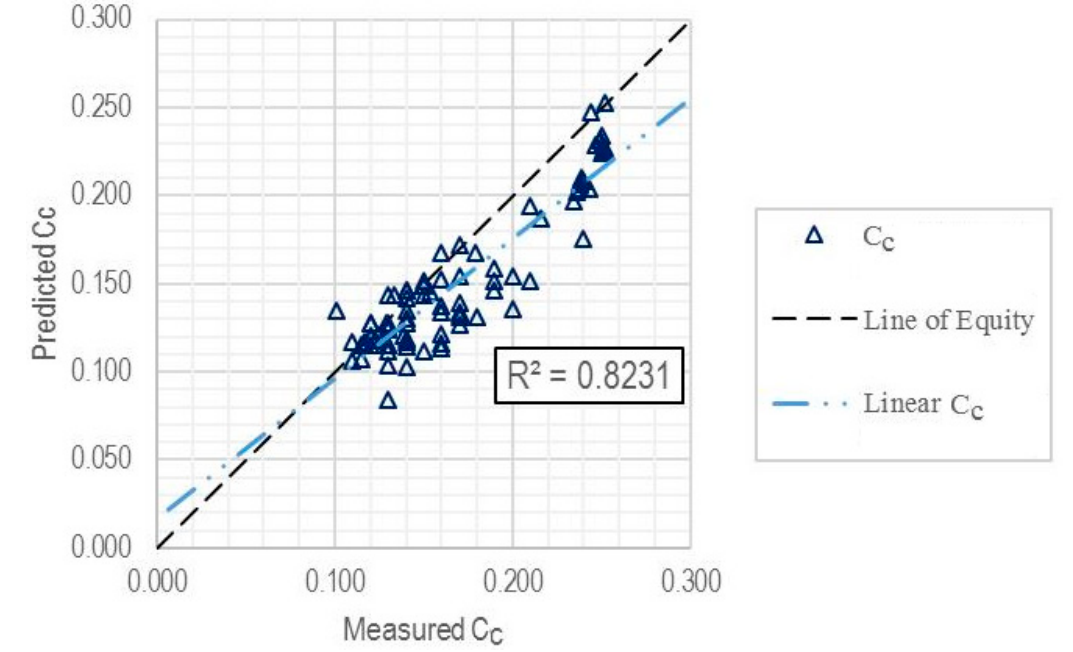
Figure 6. Predicted versus measured C c for the training subset.